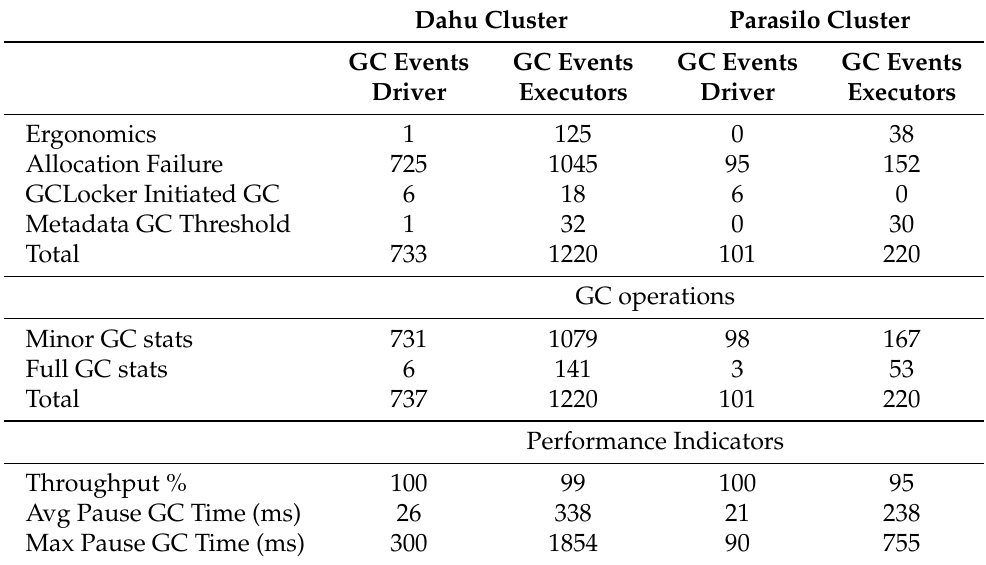
Table 10. GC Statistics’ for Stateful SUMServer Application With Backpressure over Pipeline